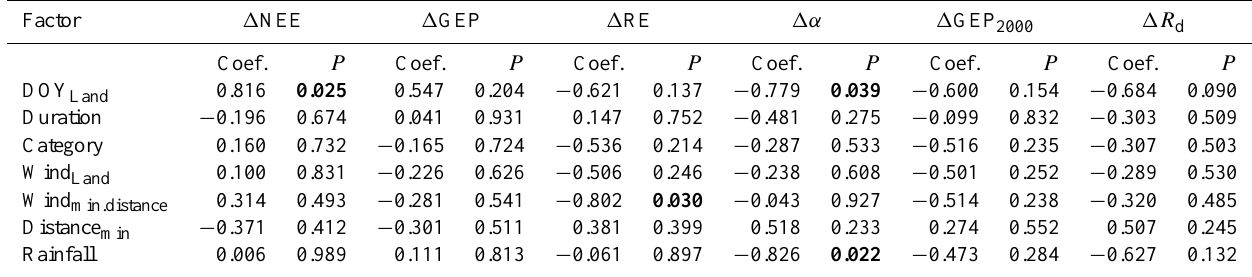
Table 3. Linear regression coefficient (Coef.) and significance probability ( P) between daily ecosystem carbon fluxes change ( 1 NEE, 1 GEP and 1 RE), model parameters change of light response curves ( 1α , 1 GEP 2000 and 1R d ) before and after typhoon made landfall and typhoon characteristics (DOY Land , duration, category, wind Land , wind min.distance , distance min , rainfall). The daily data from 2009 to 2012 for Yunxiao (YX) and Gaoqiao (GQ) were used. The p value less than 0.05 is marked as bold number.